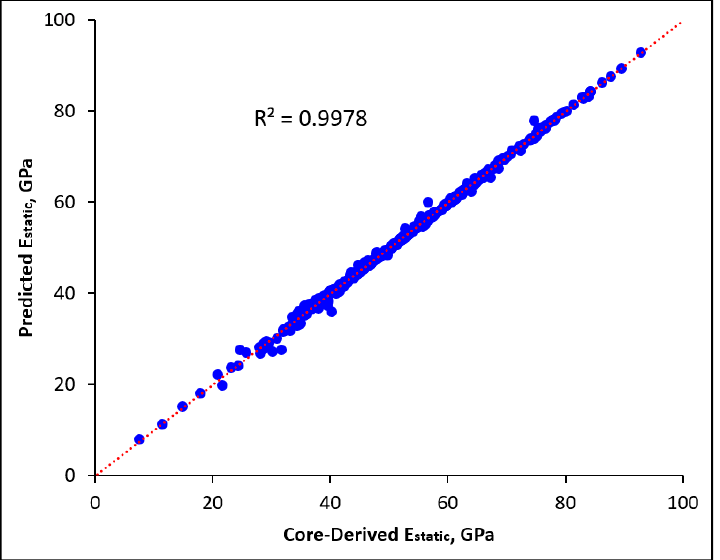
Figure 4. Cross-plot of the core-derived and predicted E static of the training dataset.